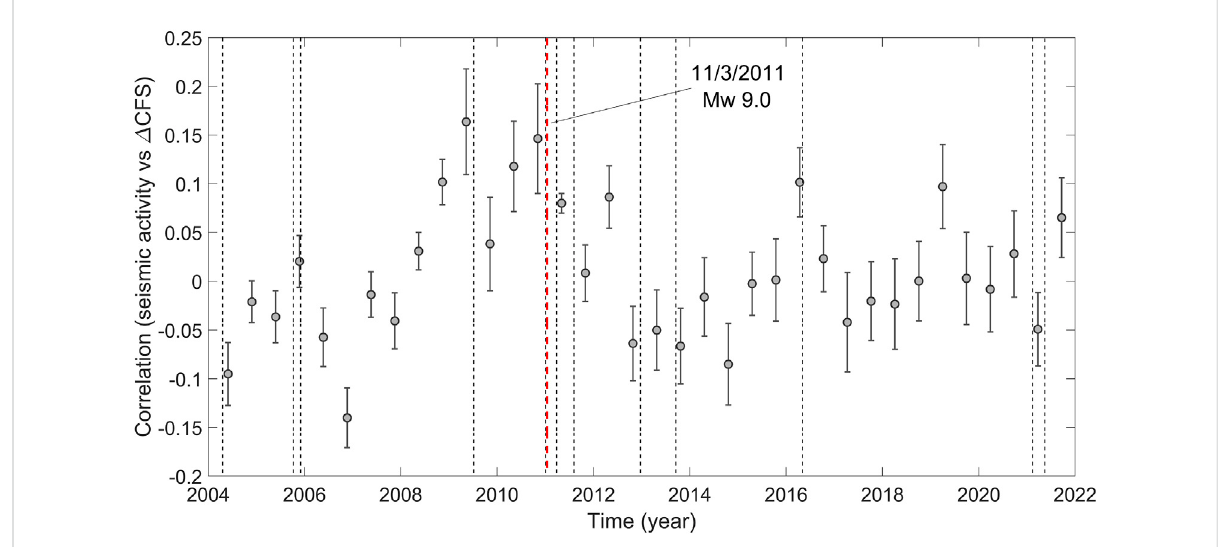
FIGURE 4 Correlation between Δ CFS and seismicity in Southern Japan, between 2004 and 2021. The scatter plot is realized by taking into account earthquakesthathappenedatlatitude35 ° – 40 ° N,longitude140 ° – 145 ° E,and-2 – 50 kmdeep,M L ≥ 4.5,USGSCatalog.Apreseismicphasefeaturedby an increase ofthe correlation, although weak, isdetected before the Tohoku-Okiseismic sequence, mainshock 11/3/2011, M w 9.0. The dashed lines represent earthquakes with M w ≥